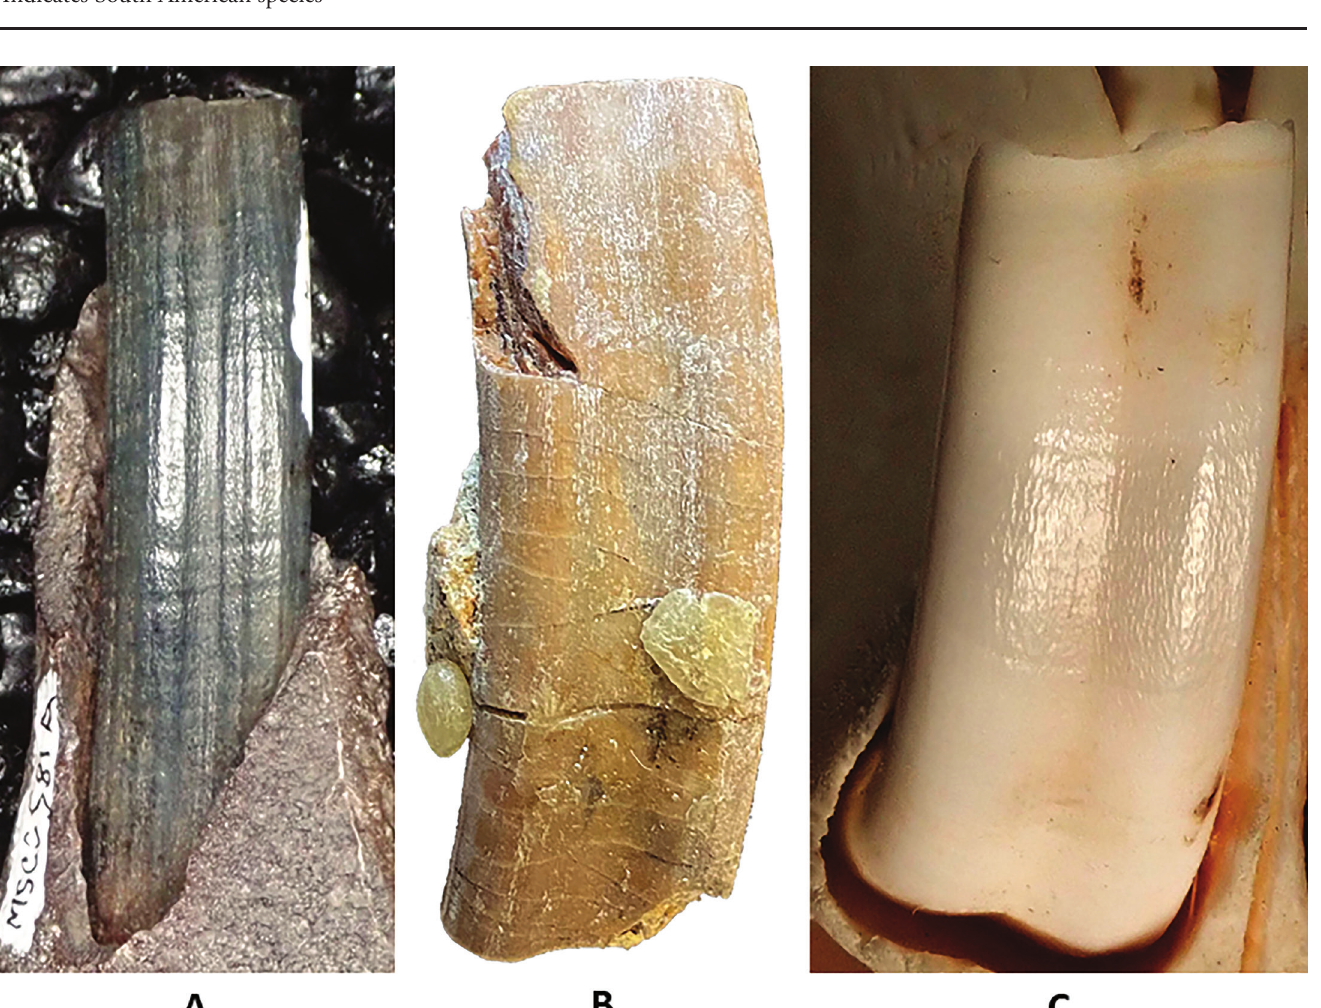
Figure 10. Anterior enamel surface of incisors. A, N eochoerus aesopi , MSCC 581, Florida; B, Hydrochoerus hesperotiganites , SDSNH 50000, California; ,. Hydrochoerus hydrochaeris , MSCC 461, zoo